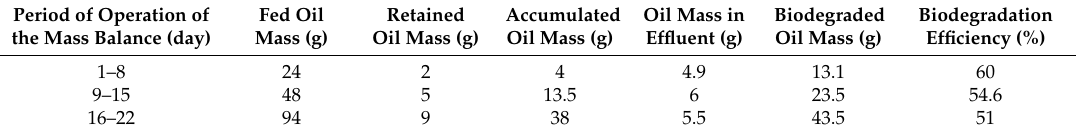
Table 2. Matter balance of activated sludge with stirring and the increase of the initial biomass. Period of Operation of the Mass Balance